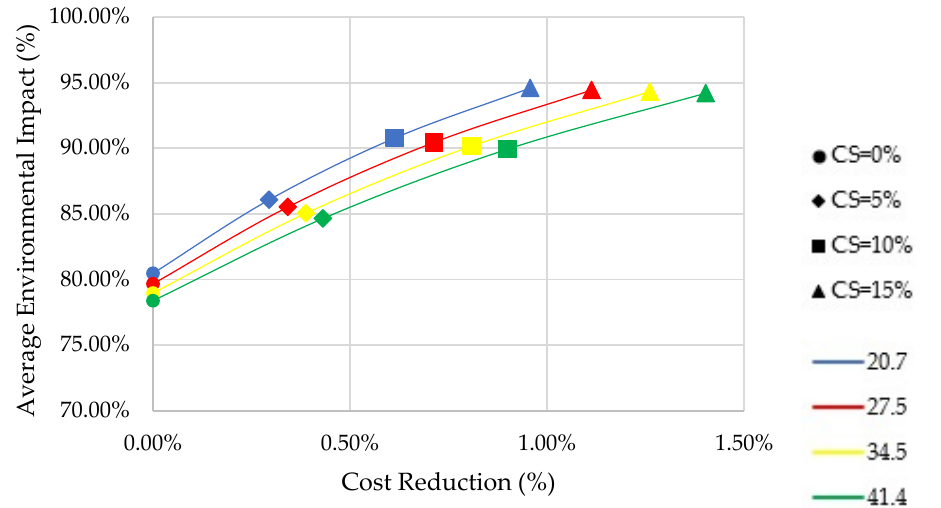
Figure 9. Three-story building environmental impact vs. cost reduction plots by concrete strength. Table 14. ADP p -value for concrete strength and average increase in emissions with increasing CS.